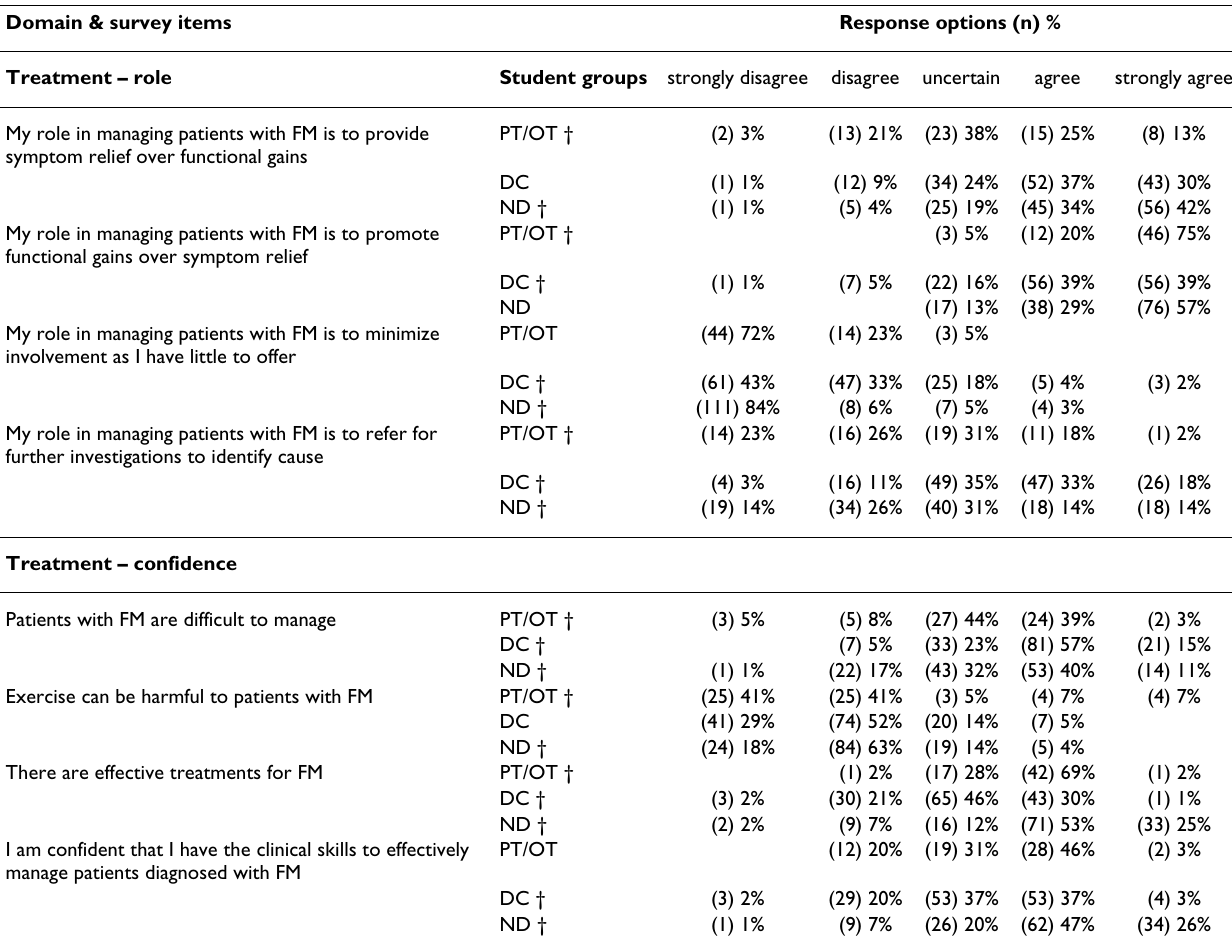
Table 3: Response data to questions on treatment of fibromyalgia Domain & survey